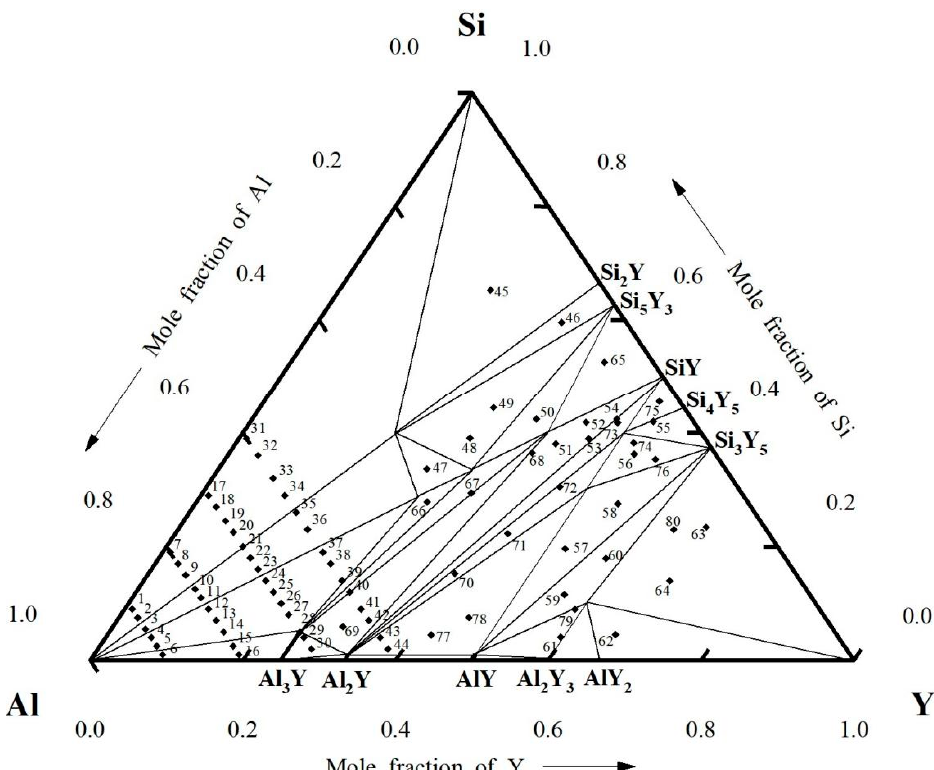
Figure 9. Constructed isothermal section of the Al–Si–Y system at 773 K based on the experimental results.